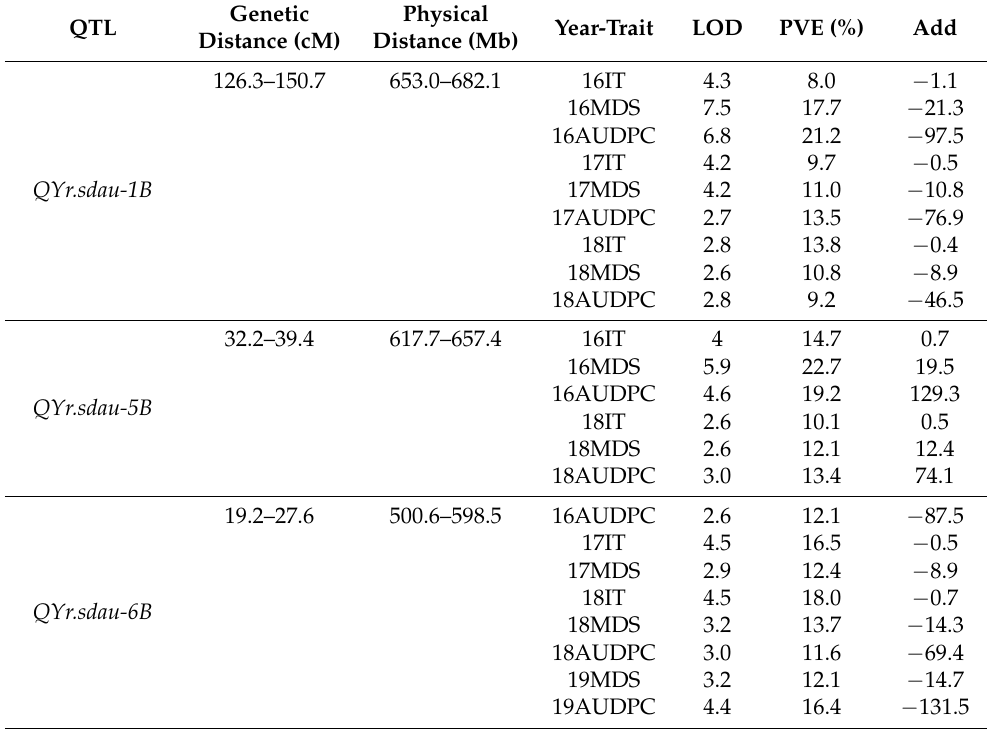
Table 2. Name, position, LOD score, phenotypic variation explained (PVE), and additive effects of quantitative trait loci (QTLs) for stripe-rust resistance at the adult stage in a population of Tutoumai x Siyang 936 identified using composite interval mapping (CIM) and the phenotypic data collected from the experiments conducted from 2016 to